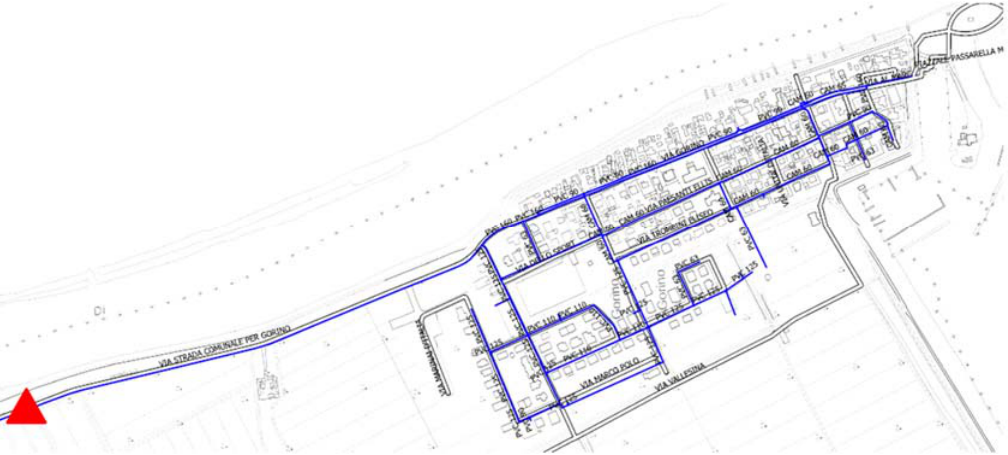
Figure 2. Diagram of the water distribution network of Gorino Ferrarese (FE). The red triangle indicates the point where the DMA’s inlet discharge and pressure are monitored.